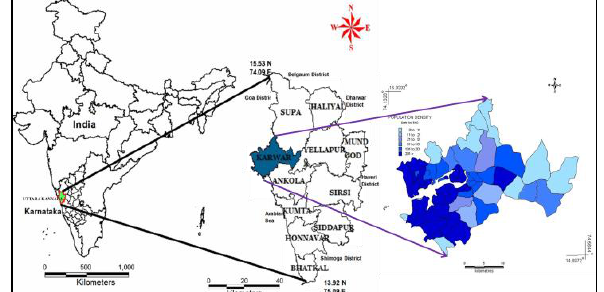
Figure 2. Method used in the